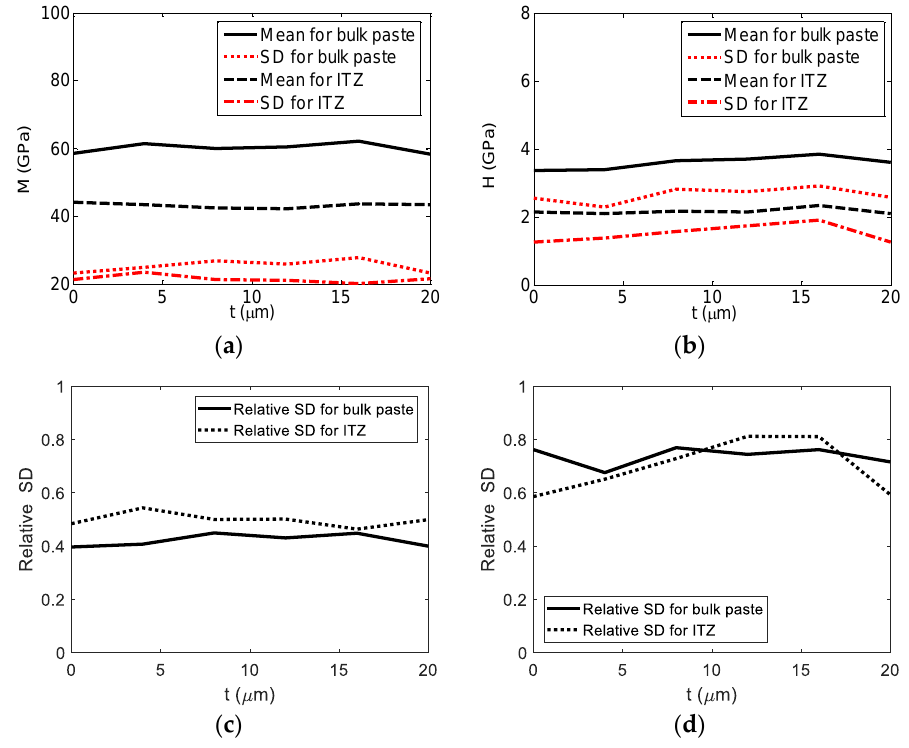
Figure 4. Statistics characteristics of the bulk paste and the ITZ: mean and SD for ( a ) indentation modulus and ( b ) indentation hardness; relative SD for ( c ) indentation modulus and ( d ) indentation hardness.